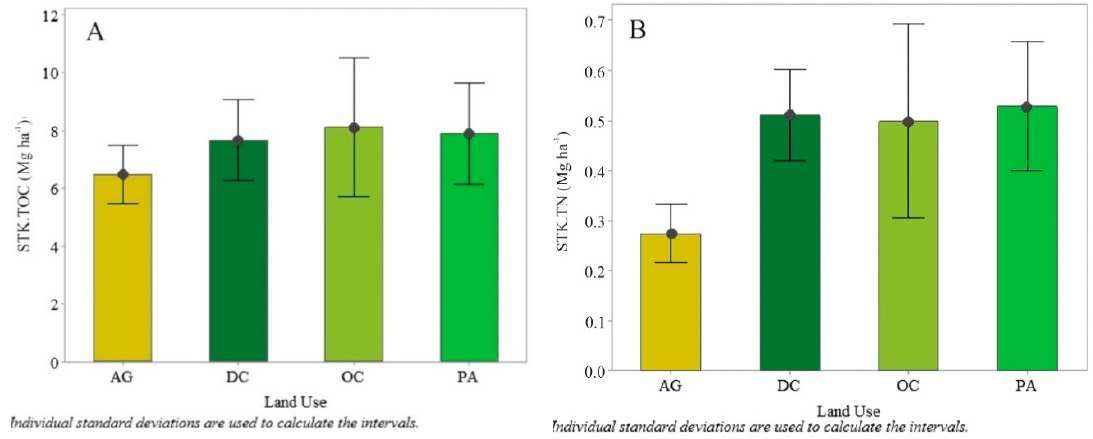
Figure 5. The stock of TOC ( A ) and TN ( B ) in the 0–30 cm layer for different land-uses in the semi-arid region of Brazil.